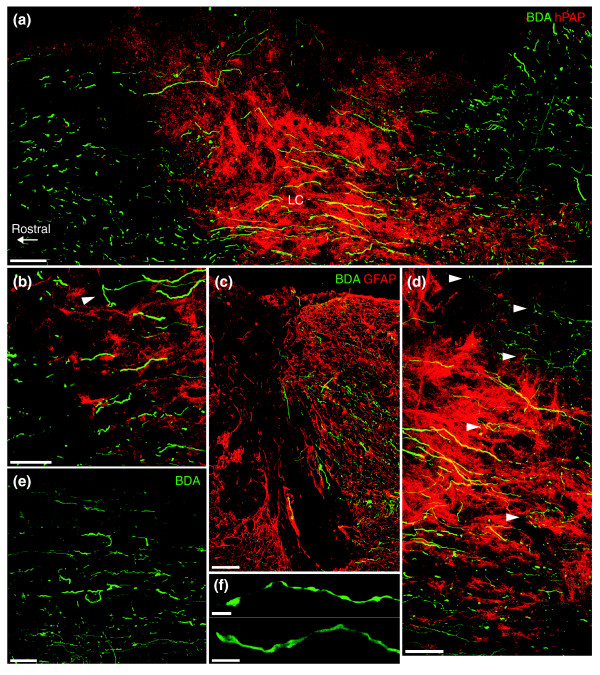
Endogenous sensory axon regeneration across GDA-transplanted dorsal column injuries at 8 days after lesion and transplantation. (a) A montaged, low-magnification confocal image scanned from a single 25-μm thick sagittal section, showing BDA-labeled ascending dorsal column axons (green) that have entered, grown within and exited a hPAP+ (red) GDA-transplanted dorsal column lesion. LC, lesion center. (b) A high-magnification image of a rostral graft/host interface showing BDA+ axons exiting the GDA graft and entering host white matter. A few axons were observed to have turned away from the interface and grown back towards the lesion center (arrowhead). (c) In control lesions, the vast majority of BDA+ axons have formed dystrophic endings and failed to leave the caudal margins of the lesion, marked by hypertrophic GFAP+ astrocytes (red). (d) A high-magnification image showing numerous BDA+ axons that have successfully crossed the host/graft interface at the caudal lesion margin. A few cut axons (arrowheads) have, however, failed to leave the caudal lesion interface and can be seen to have turned and/or formed dystrophic endings, particularly in regions containing few hPAP+ GDAs (red). (e) BDA+ axons located near the pial surface and ventral regions of cuneate white matter at 1.5 mm rostral to a GDA-bridged lesion site. (f) BDA+ axon growth cones in white matter 1.5 mm rostral to the lesion site often display streamlined growth cones indicative of rapid growth. Scale bars: (a,c) 100 μm; (b-e) 50 μm; (f) 5 μm (top) and 10 μm (bottom).